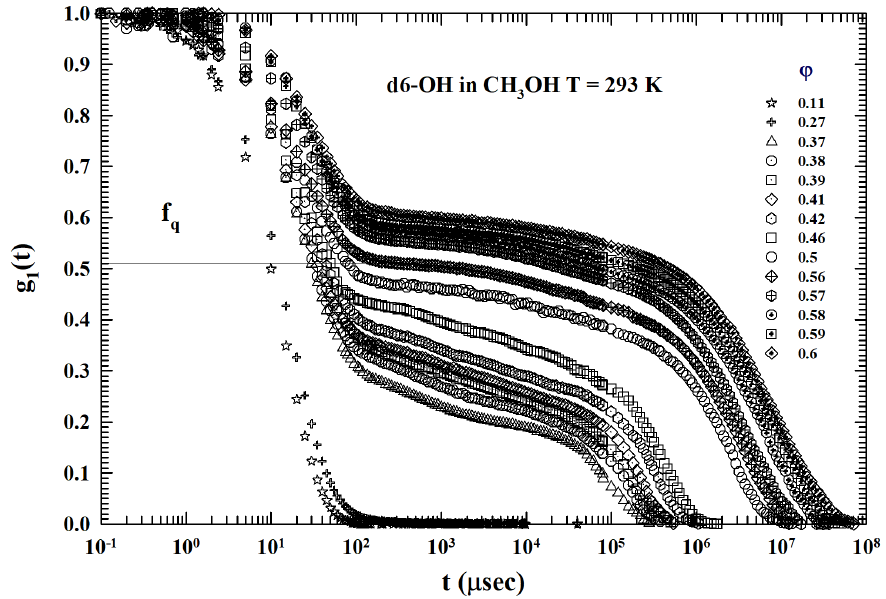
Figure 8. The ISFs of dendrimer (the same of Figure 4) in methanol for 0.11 < ϕ < 0.6. In the actual case (water as solvent): at the same T and at all the used ϕ , only some of the reported density correlations seem to show the AHS logarithmic decay (0.37 < ϕ < 0.39). In addition, the resulting DWFs are considerably lower than that measured previously. This is the effect of the solvent hydrophobicity on the solute (dendrimer with only OH terminal